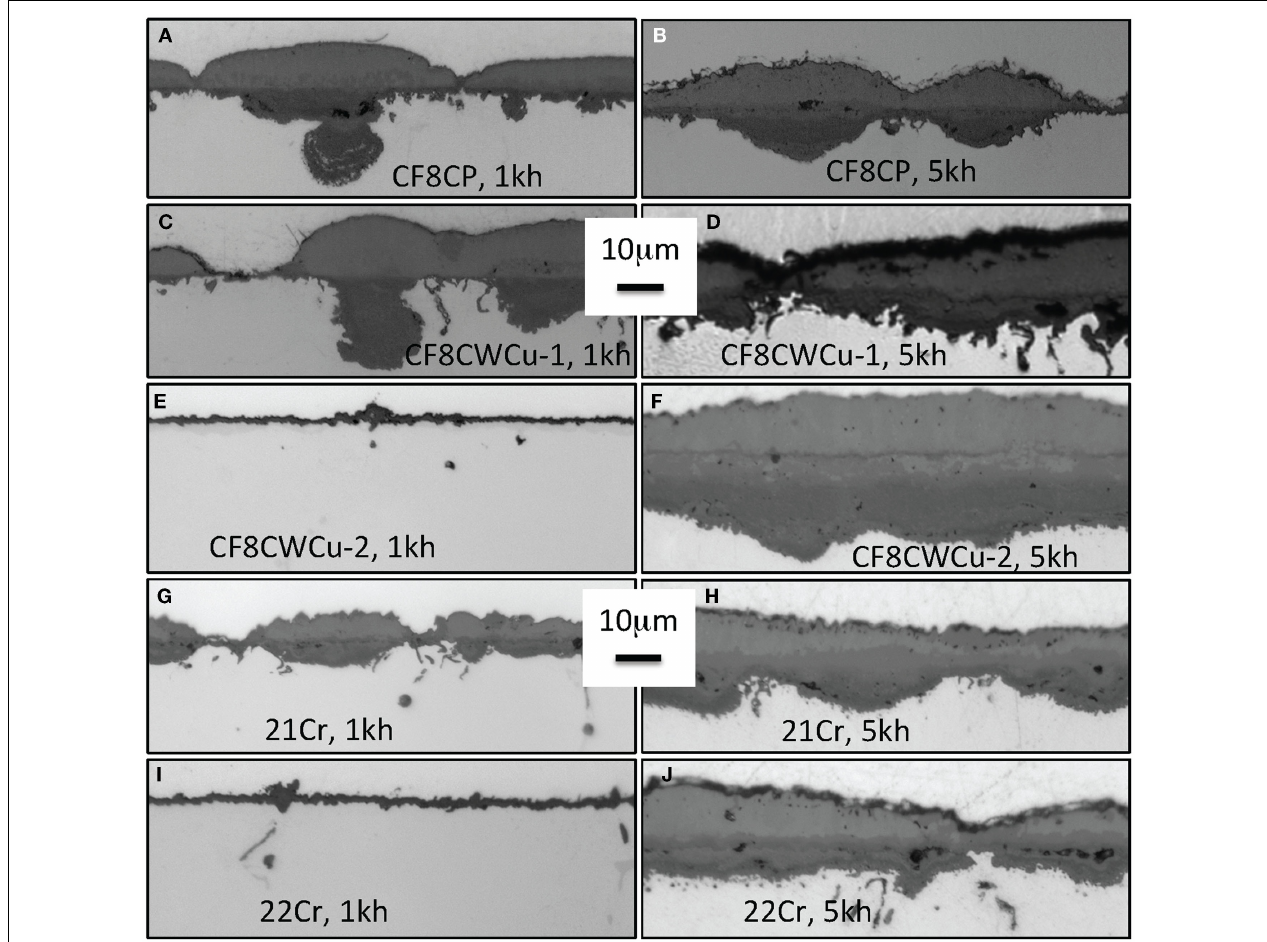
FIGURE 3 | Cross-section optical micrographs after exposure in air +++ 10% H 2 O at 700°C, (A) CF8CP, 1000h, (B) CF8CP, 5000h, (C) CF8CWCu-1, 1000h, (D) CF8CWCu-1, 5000h, (E) CF8CWCu-2, 1000h, (F) CF8CWCu-2, 5000h, (G) 21Cr–15Ni, 1000h, (H) 21Cr–15Ni, 5000h, (I) 22Cr–17.5Ni, 1000h, and (J) 22Cr–17.5Ni, 5000h